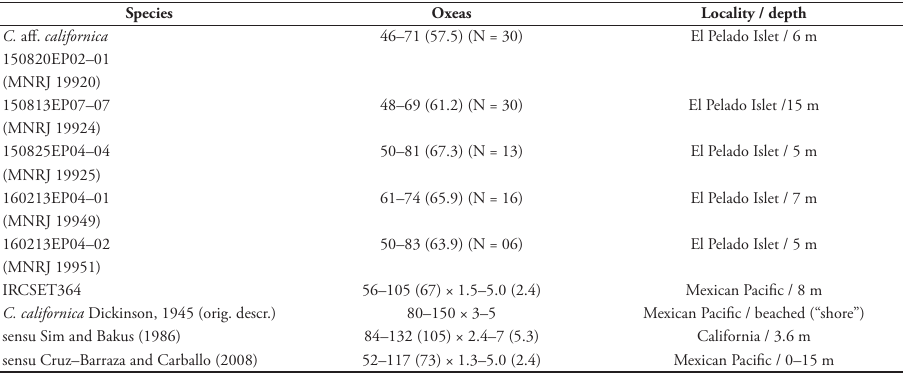
table 3. Callyspongia ( C. ) californica Dickinson, 1945 and C. ( C. ) aff. californica : Morphology of spicules spicule (in micrometres), locality and depth for specimens studied here, and from the literature. Spicule morphometrics are in micrometres as range with the mean in